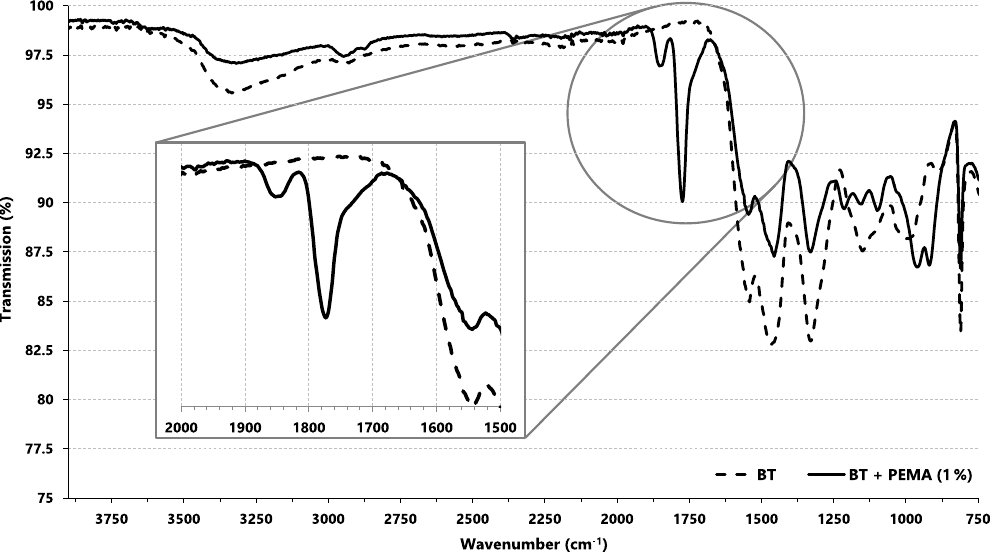
Figure 2. Comparison of ATR transmission spectra of plain Basotect ® (BT) and PEMA functionalized BT (not normalized). The figure shows untreated and PEMA functionalized BT for comparison. The signals at 1775cm − 1 and 1850cm − 1 account for tethering of PEMA to the BT